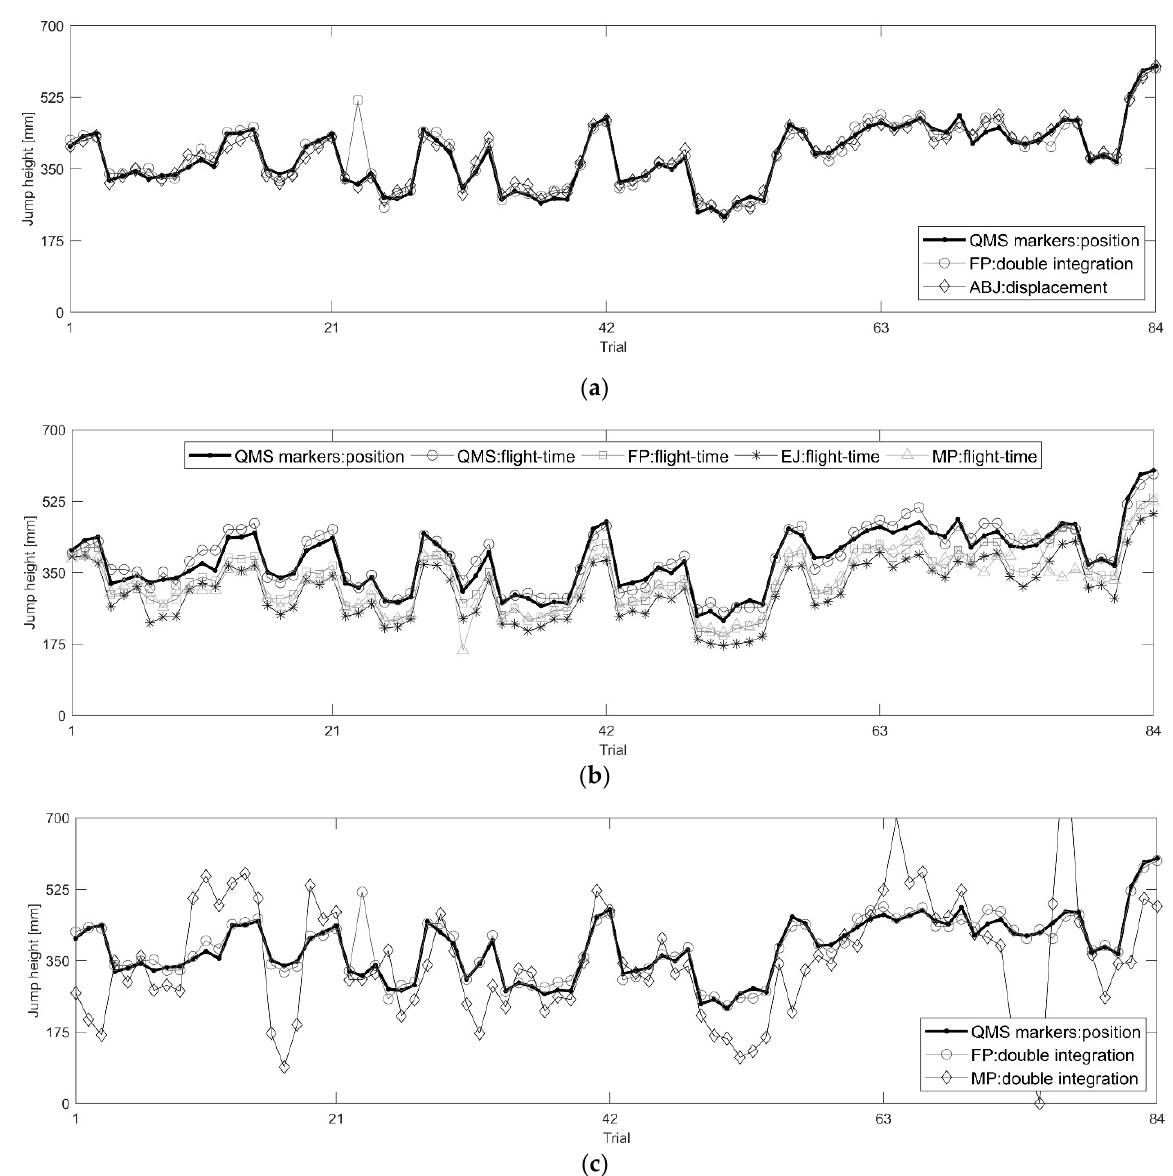
Figure 3. Comparison of jump height for 84 trials obtained by: ( a ) the QMS markers position, the FP double integration method, and ABJ displacement; ( b ) the QMS markers position, FP, EJ, and MP by using the flight-time method; ( c ) the QMS markers position and the FP and MP by double integration.